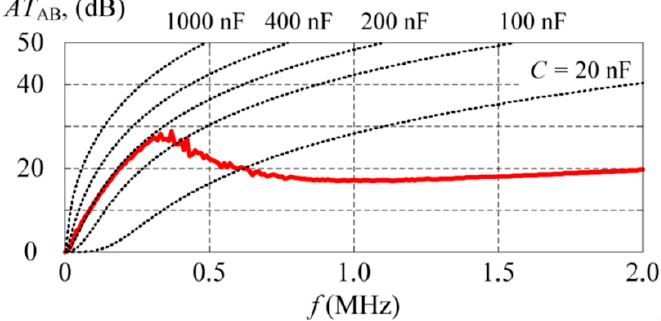
Figure 9. Insertion loss characteristics of the experimental LC filter with the ideal characteristics given for different values of the capacitances and a fixed inductance of L = 66 μ H.